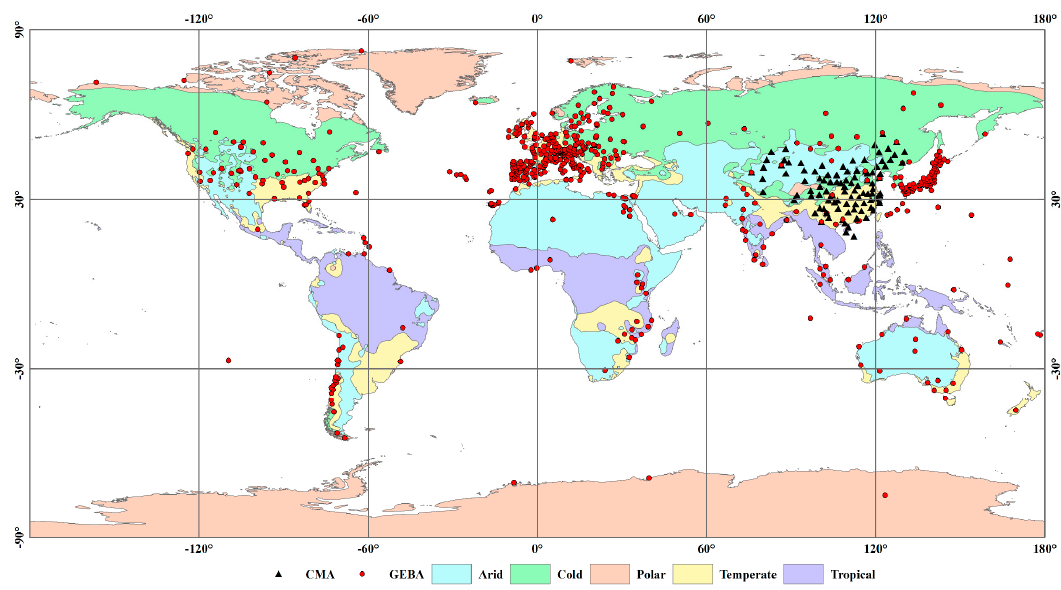
Figure 1. Geographical distribution of observation sites and Köppen climate zones.